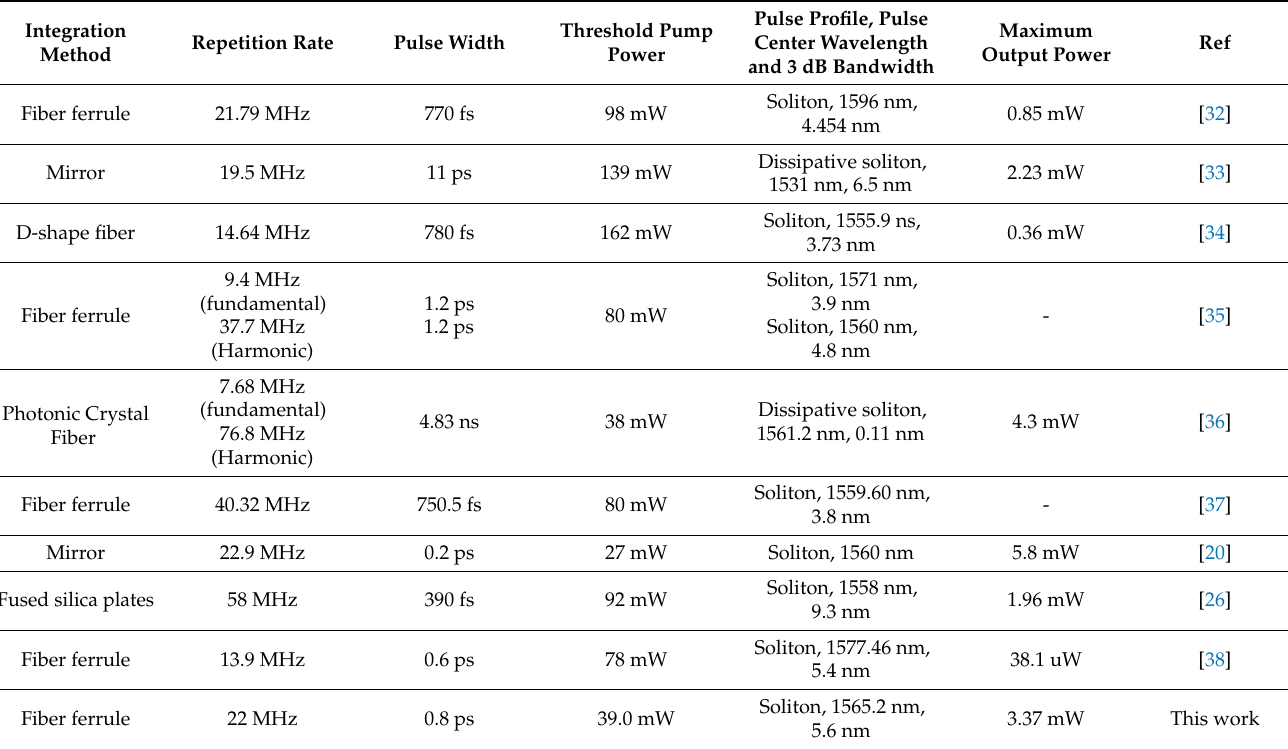
Table 1. Summary of work on mode-locked pulsed fiber laser covering C- and L-band regions using GO